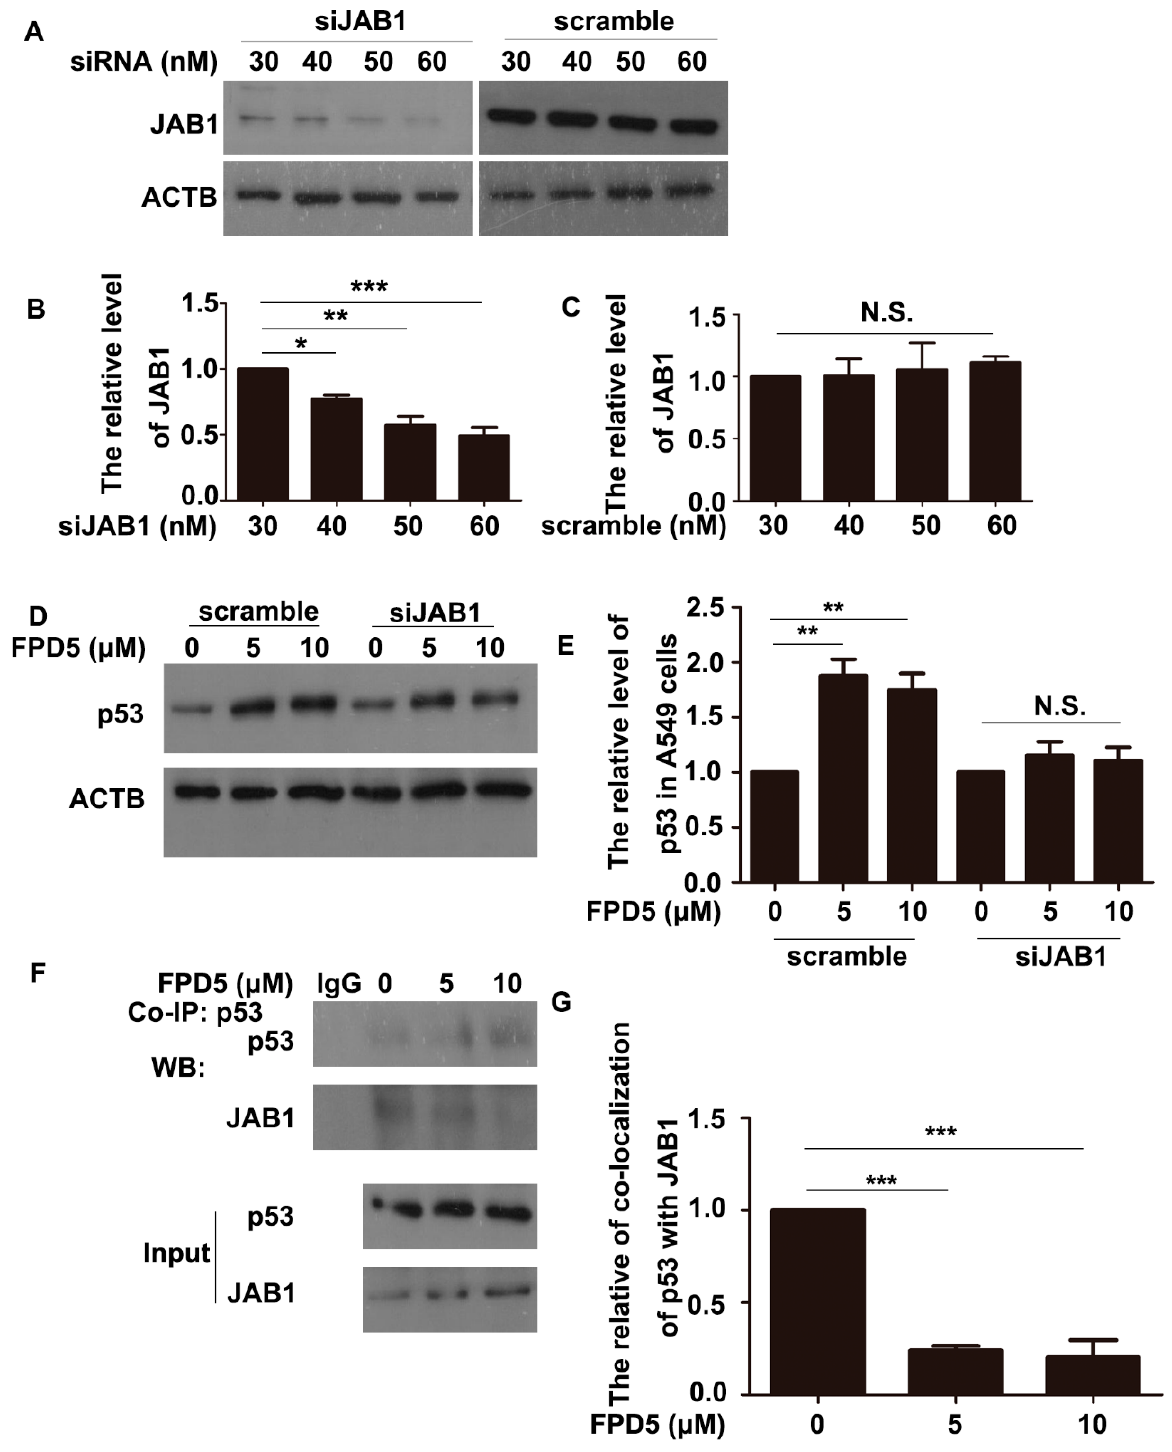
Figure 3. ESD improved p53 level by JAB1 and inhibited the interaction between JAB1 and p53. ( A – C ) Cells were transfected with scramble siRNA (scramble) or siRNA-JAB1 (siJAB1) for 24 h. The protein level of JAB1 was analyzed by Western blot, and the relative protein level of JAB1 was calculated as the ratio of JAB1 to ACTB. ( D , E ) Western blot analysis of p53 in A549 cells transfected with 60 nM scramble siRNA (scramble) or siRNA-JAB1 (siJAB1) for 24 h before exposure to 5, 10 μ M FPD5 for 24 h. Relative protein level of p53 calculated as ratio of p53 to ACTB. ( F , G ) Co-immunoprecipitation (Co-IP) of JAB1 with the p53 protein in A549 cells. Data are mean ± SEM. * p < 0.05, ** p < 0.01, *** p < 0.001, N.S., not significant, n = 3.